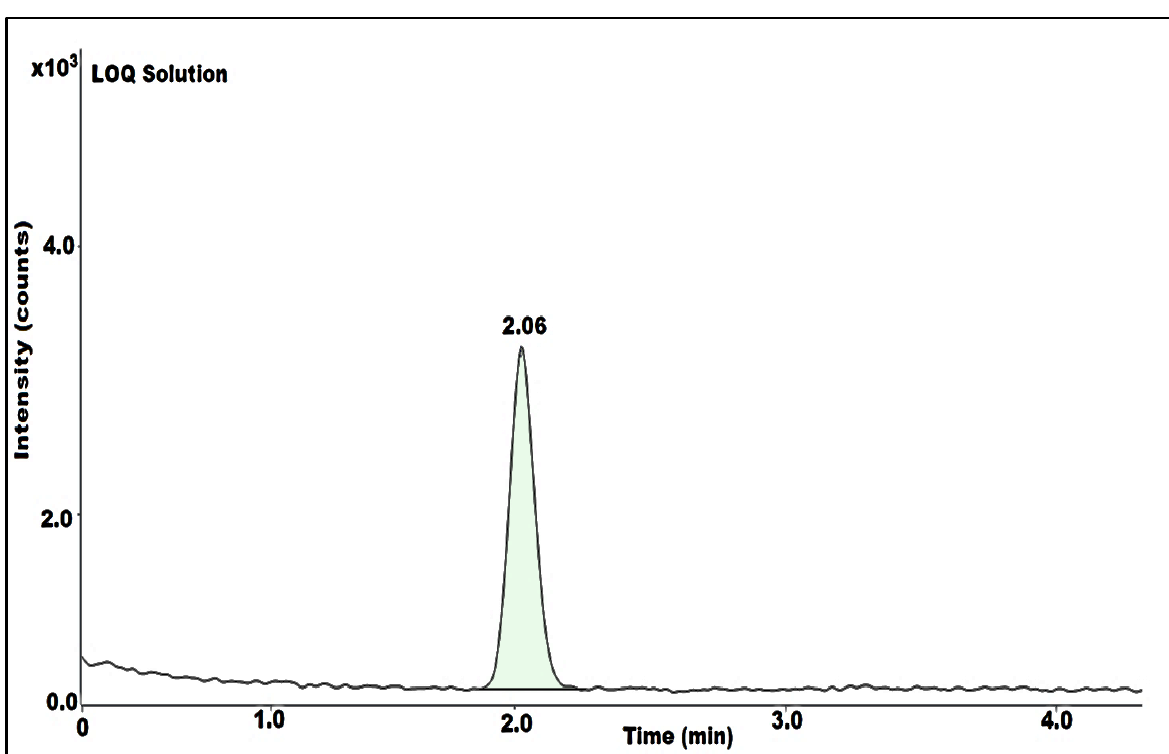
Figure 6. LOQ solution chromatogram.